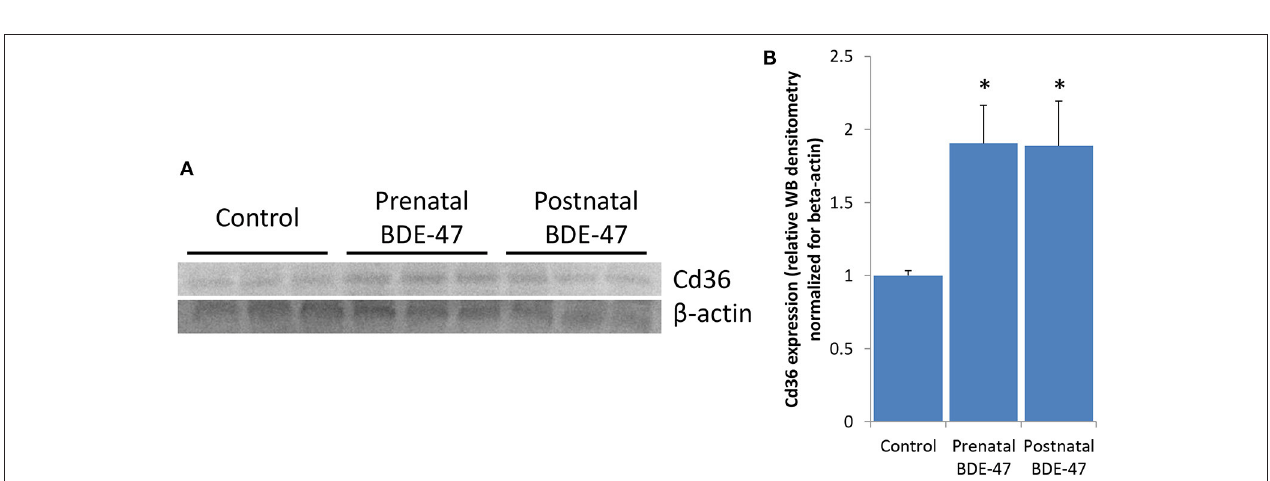
FIGURE 5 | Expression of Cd36 protein is increased in livers of 10 months old mice exposure to BDE-47 during prenatal or neonatal development: (A) –expression of Cd36 measured by western blot; (B) –quantification of Cd36 protein expression (Mean ± SE, n = 3/exposure group, p -value is for T -test).